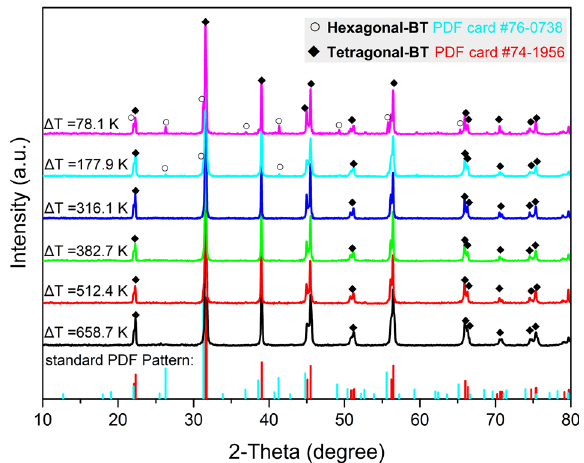
Fig. 1 Polymorphic selection behavior of solidi fi ed BT. Room-temperature XRD patterns of the solidi fi ed BT obtained by triggering nucleation at